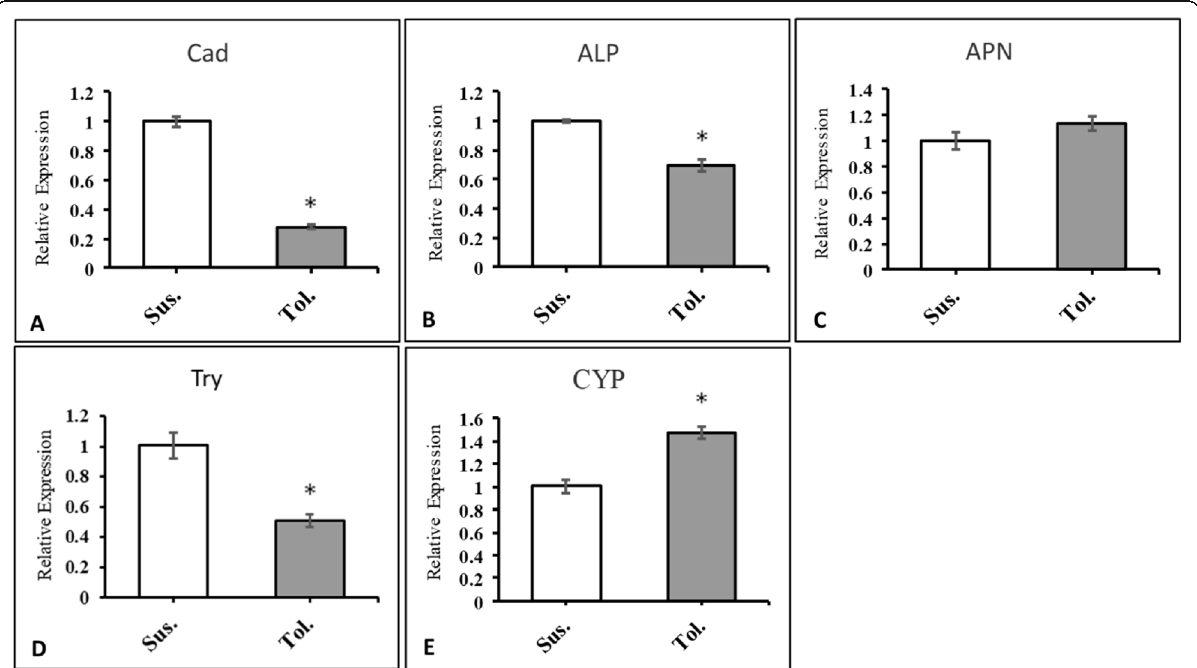
Fig. 3 qPCR analysis: Relative fold change expression of Cad (cadherin), ALP (alkaline phosphatase), APN (aminopeptidase N), Try (trypsin) and CYP (cytochrome P450) in midgut of susceptible (Sus.), and Cry1C -tolerant (Tol.) strain of Spodoptera littoralis . Asterisks indicate significant difference ( P < 0.05). Bars represent standard